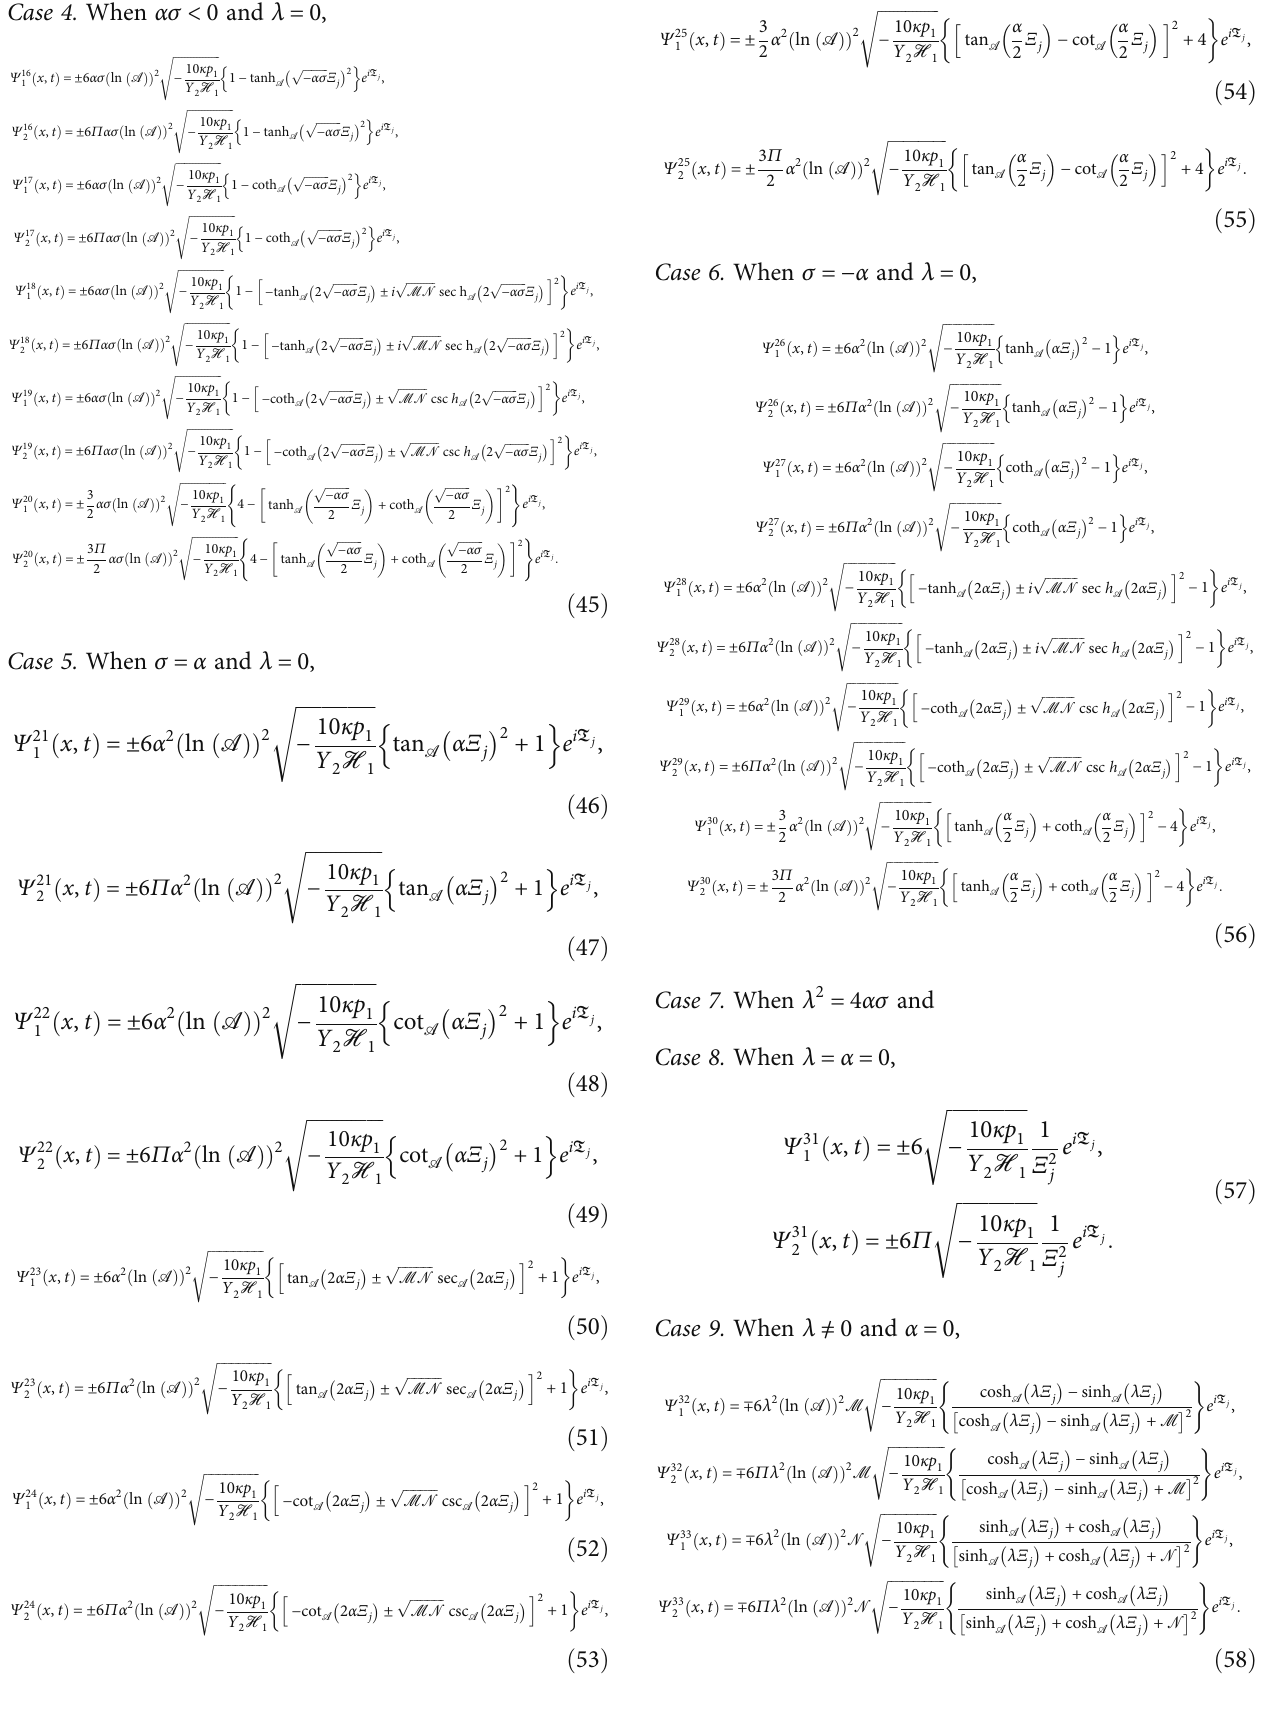
ffiffiffiffiffiffiffiffiffiffiffiffiffiffiffiffi